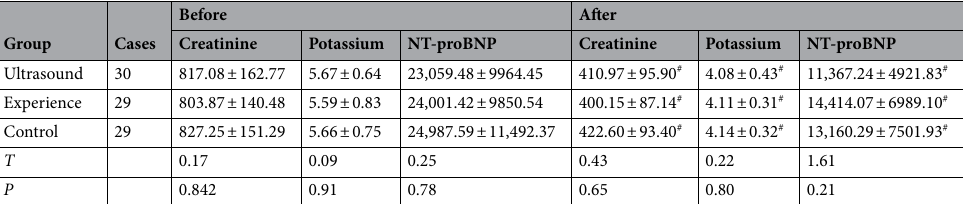
Table 3. Comparison of creatinine, potassium, and NT-proBNP levels among three groups before and 24 h after CRRT. # Statistical significance compared with before CRRT, P < 0.05.